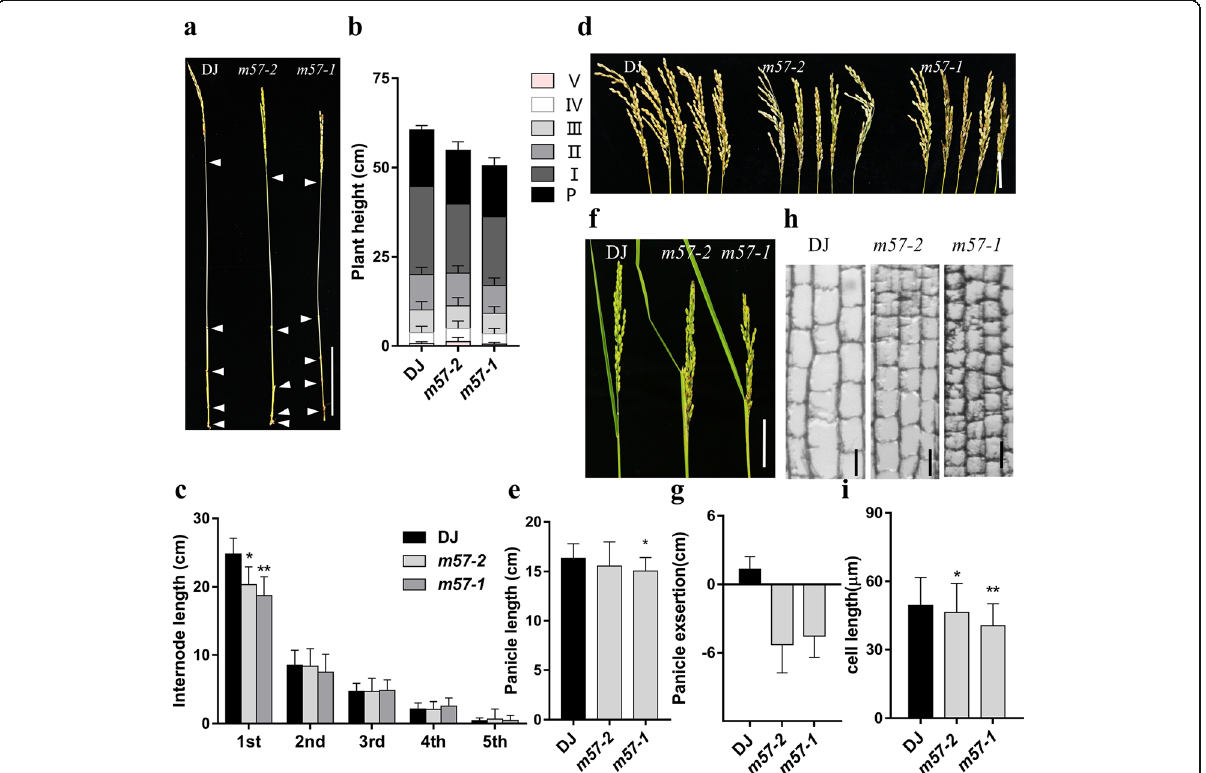
Fig. 2 Characterization of osmads57 plants. a Plant height of wild type and mutants . Bars=10cm. b Plant height and the length of its components of wild type and mutants. P, panicle; I, the uppermost internode; II, III, IV, the second, third, and fourth internodes counted from the uppermost internode, respectively. c Individual internode lengths of wild type and mutants. d The phenotype of panicles. Bars =5cm. e Panicle length of wild type and mutants at maturity. f Panicle exsertion of wild type and mutants. Bars =2cm. g Measurement of panicle exsertion of wild type and mutants. h Longitudinal sections of the uppermost internodes of wild type and mutants. Bars =50 μ m. i Quantitation of cell length of the uppermost internode of wild type and mutants. DJ, wild type; m57 – 2 , osmads57 – 2 ; m57 – 1 , osmads57 – 1 . Three independent experiments were conducted with similar results. The data are means± SD ( n =15). Error bars indicate SD. The statistical significance of the measurements was determined by Student ’ s t -test. Asterisks indicate the significant difference between osmads57 and wild type ( t – test, * P <0.05, ** P <0.01 or *** P